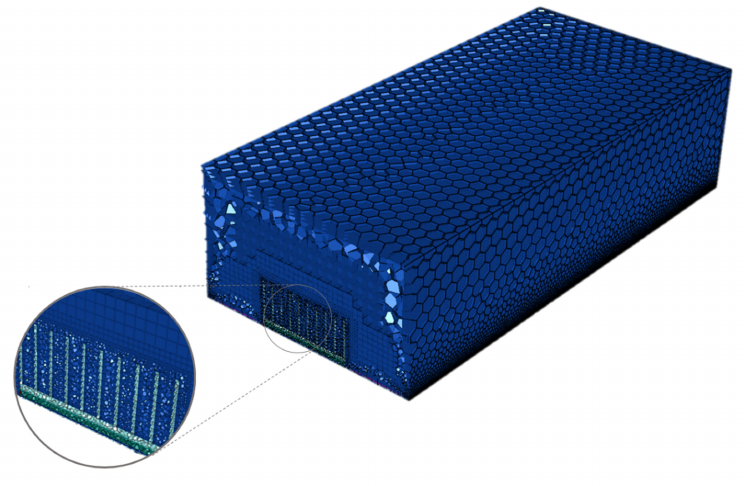
Figure 11. Polyhexcore